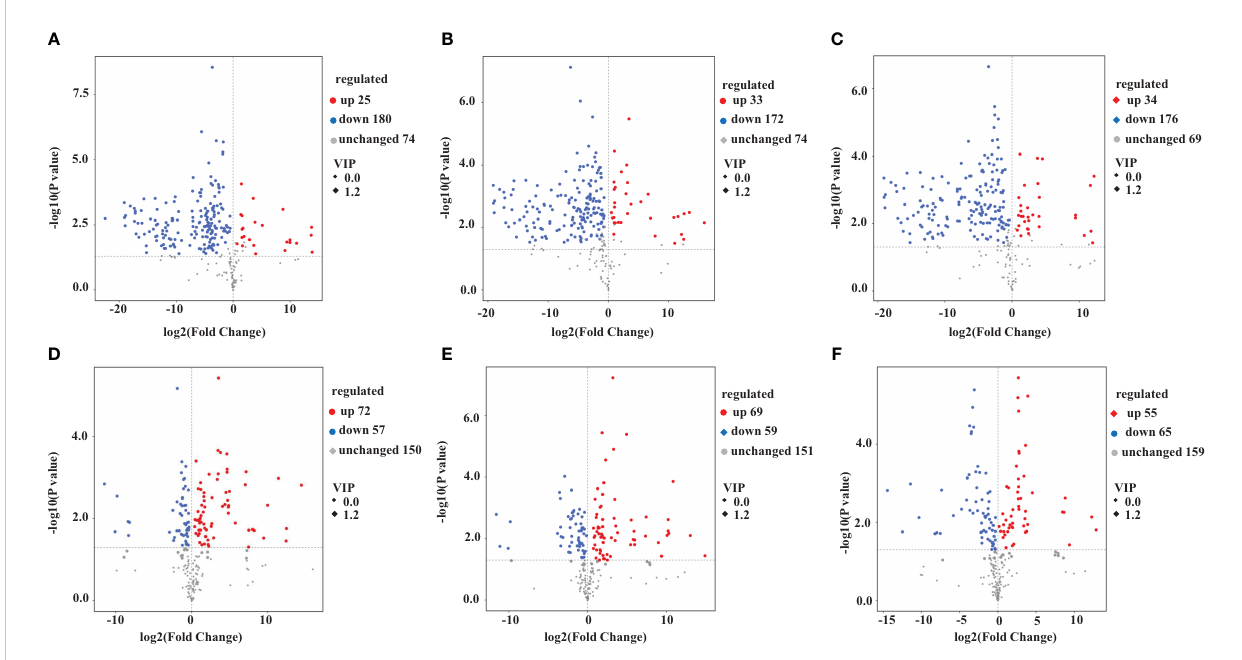
FIGURE 3 Volcano plot of the differentially accumulated metabolites among the different Pueraria varieties. Pairwise comparisons YS vs. HS (A) , YS vs. FG (B) , YS vs. GL (C) , HS vs. FG (D) , HS vs. GL (E) , and FG vs. GL (F) .